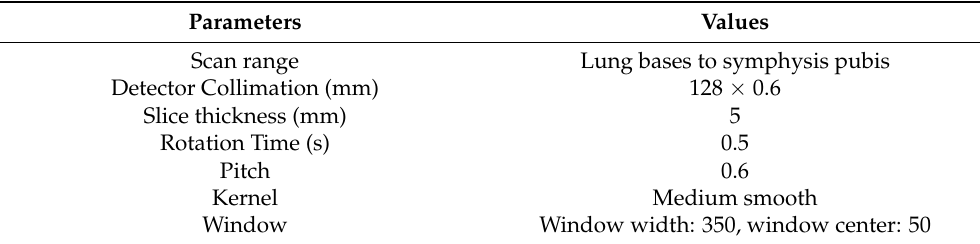
Table 1. Constant scanning parameters for abdominal CT used to scan the